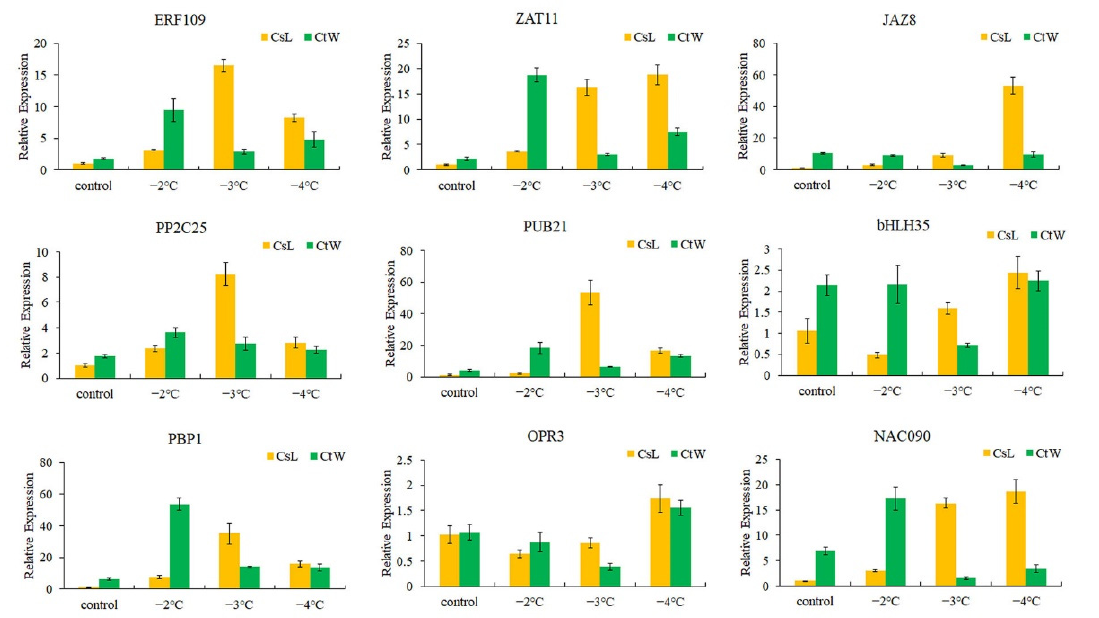
Figure 6. The relative expression levels of nine hub genes by qRT-PCR. 18S was used as the internal control. Error bars indicate SD.